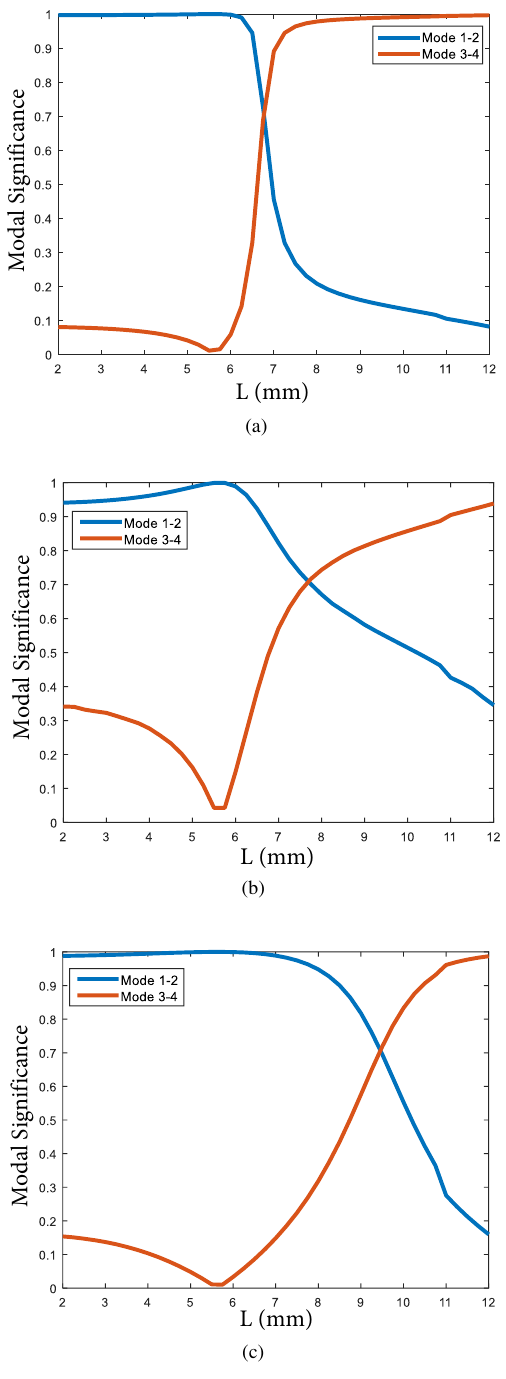
Figure 10: Modal significance for ring-type reflectarray ele- ments. (a) h=2 mm. (b) h=6 mm. (c) h=10